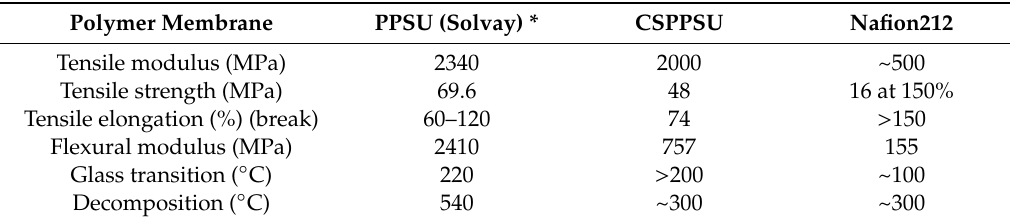
Figure 4. Stress–strain properties of ( a ) Nafion212 (t = 0.050 mm) and ( b ) CSPPSU (t = 0.066 mm) membranes at room temperature. Table 1. Mechanical and thermal properties of PPSU, CSPPSU and Nafion212 membranes.